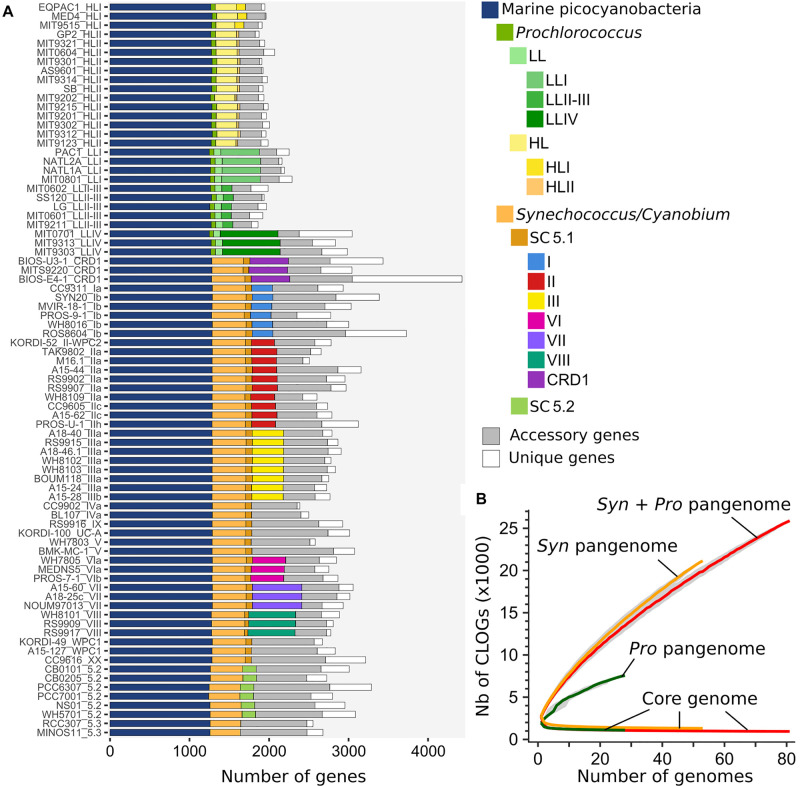
Core, accessory and pan genomes of marine picocyanobacteria. (A) Distribution of clusters of likely orthologous genes (CLOGs) in picocyanobacterial genomes. A CLOG is considered as core in a taxonomic group if it is present in ≥90% of the strains within this group. Sets of core CLOGS are inferred only for taxonomic groups with more than 3 genomes. Strains are labeled as strain_subclade (or higher taxonomic level when no sub-clade has been defined). (B) Evolution of the pan and core genomes for an increasing number of picocyanobacterial genomes (red, 81 genomes), Synechococcus/Cyanobium (orange, 53 genomes) and Prochlorococcus (green, 28 genomes). The gray zone around each curve represents the first and third quartiles around the median of 1,000 samplings by randomly modifying the order of genome integration.